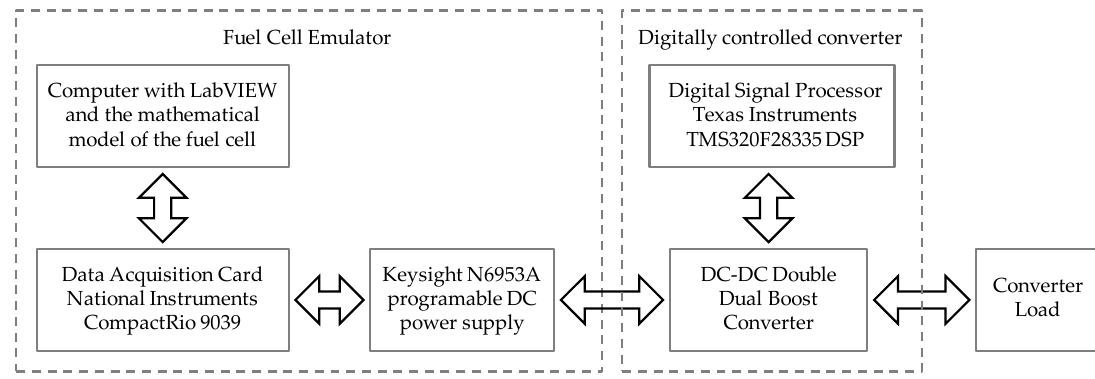
Figure 1. The full hardware in the loop system developed for this article.